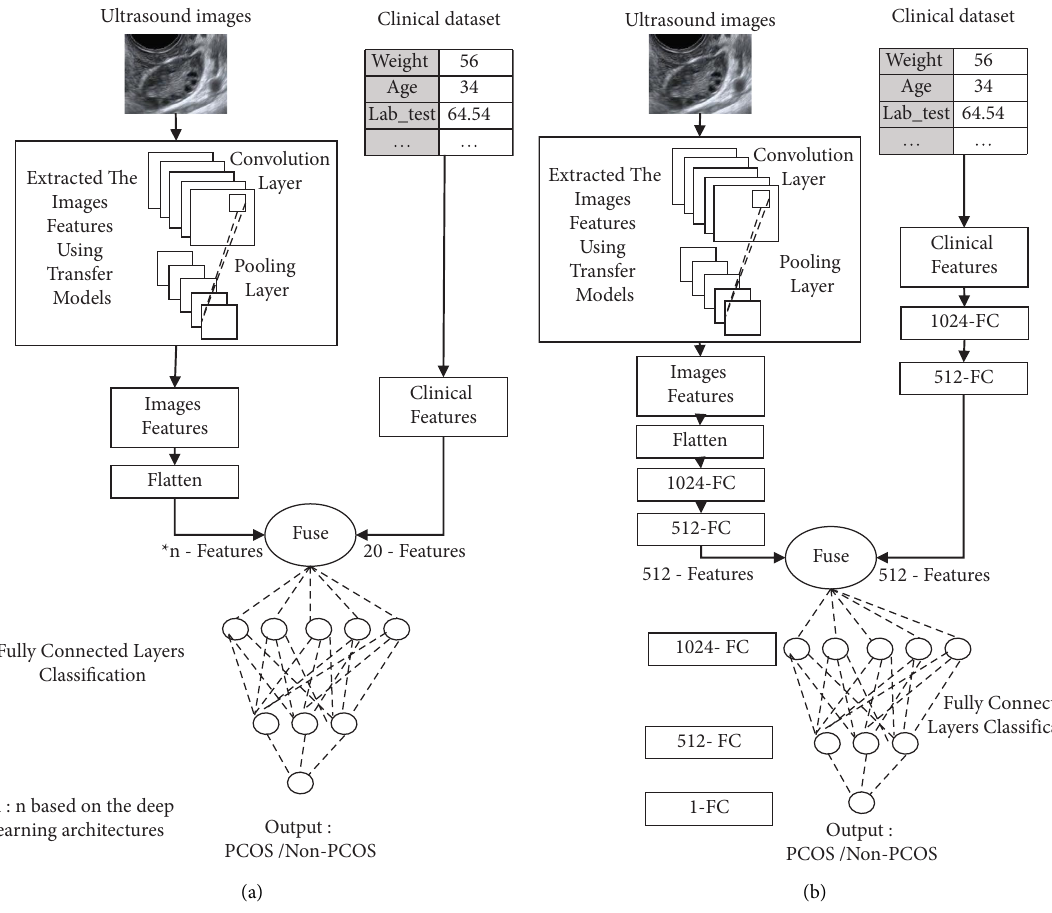
Figure 3: Diagram of the model for diagnosis of the PCOS by combining the image with the patient clinical dataset. (a) Joint fusion type II and (b) joint fusion